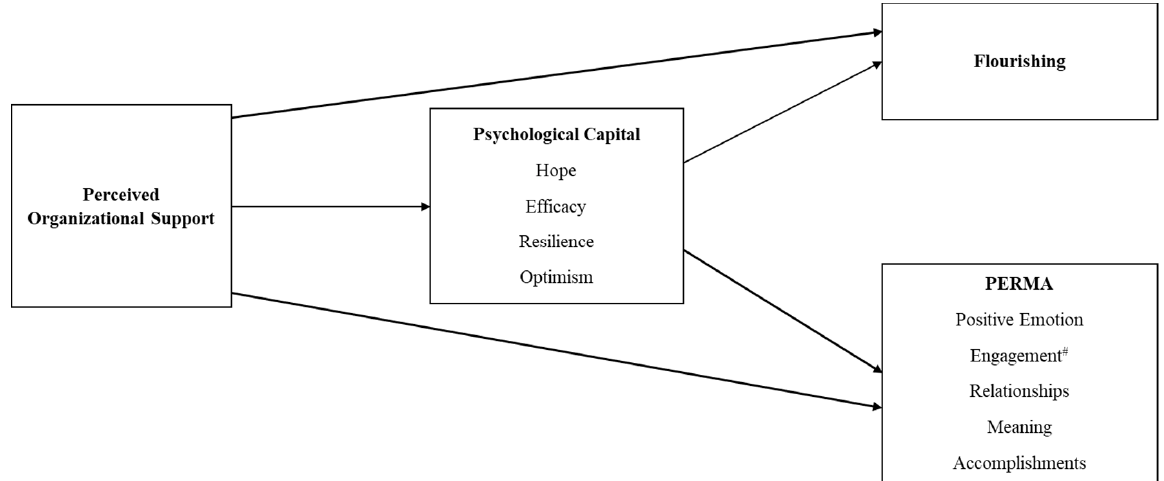
Figure 3. Consolidated Model of the Relationships between Perceived Organizational Support, Psy- chological Capital, Flourishing, and PERMA. (Note. # Relationship between perceived organizational support and engagement is non-significant. All other relationships are statistically signifi- cant).